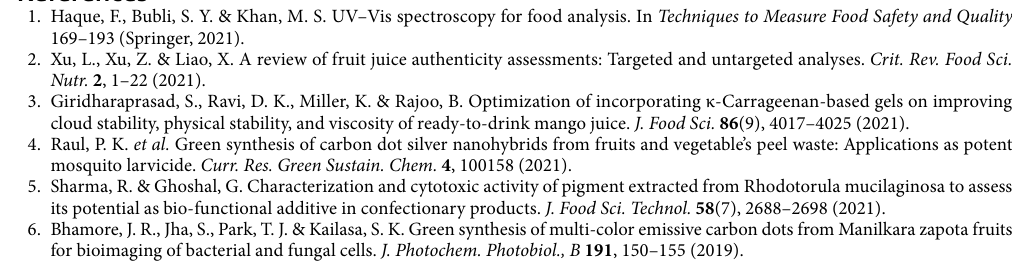
temperatures have spectral peaks of 700 nm. Spectral emission was observed at 700 nm, 646 nm, and 454 nm, total carotenoids, polymethoxyavons, and chlorophyll, respectively; the most intense peaks represent chlorophyll and carotenoids in these samples. Fewer carotenoids were observed at 60 °C and 80 °C, and the amount of vita- mins was reduced due to heat. As observed from the results, orange juices are more influenced by temperature than mango juices. The spectroscopic investigation of fluorescence quantum yields of samples were carried out and results of 0.10 and 0.37 correspond to mango and orange juices. Additionally, the lifetime of mango and orange juices was investigated. The pH values of the juices were measured by a pH meter and resulted in regions of 4.02–4.72 and 3.52–3.73 for mango and orange juices, respectively. Using fresh juices was more important than stored, heat stored juices, and the researcher may investigate for other natural juices stored in the fridge. Data availability The data are included with in the article.